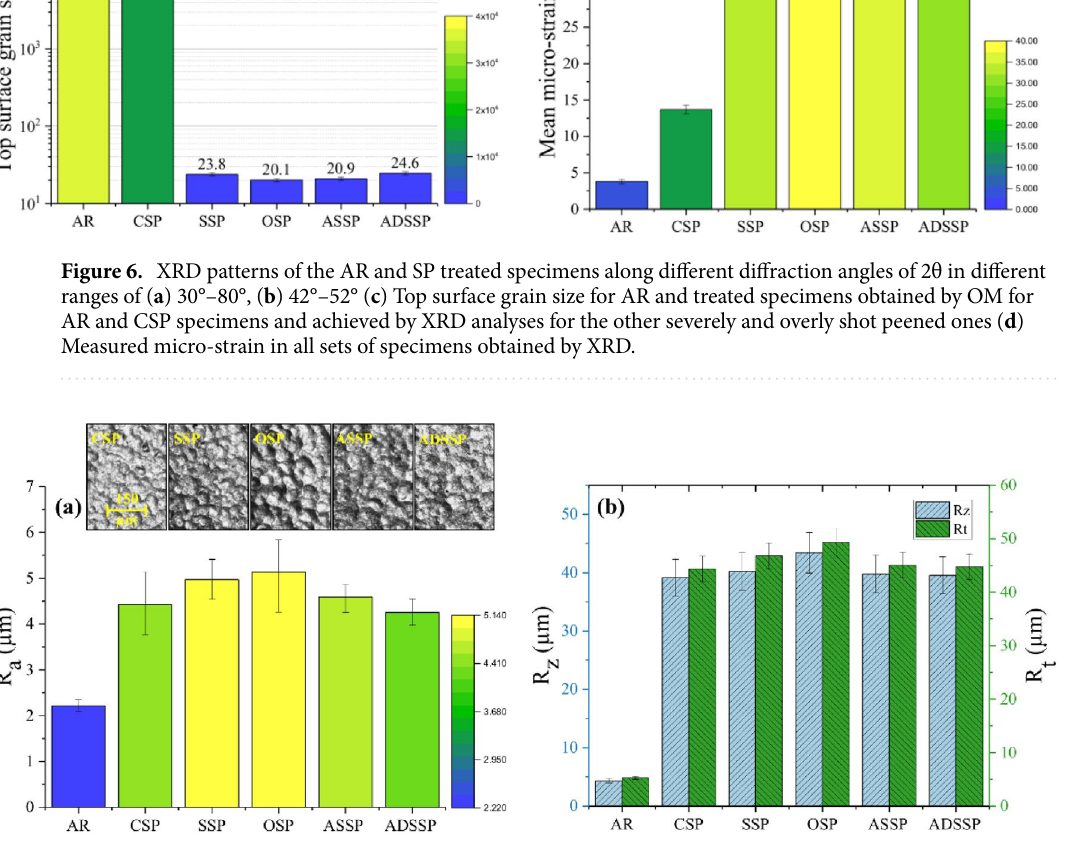
Figure 7. ( a ) Surface morphology of the SP treated specimens and the corresponding surface roughness in terms of R a ( b ) Values of surface roughness in terms of R z and R t